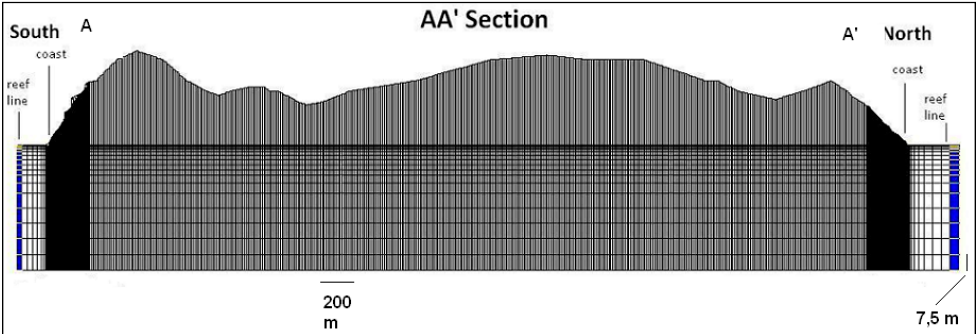
Figure 9 . AA’ section, black zones represent the most refined part of the model domain (1 m cells). For the vertical discretization, 18 layers have been set. The layer thickness increases from the surface to the bottom of the model (at − 60 m respect to the RL) from a minimum value of 0.5 m for first four layers to a maximum of 7.5 for the last three. Constant head (1352 m above RL) and